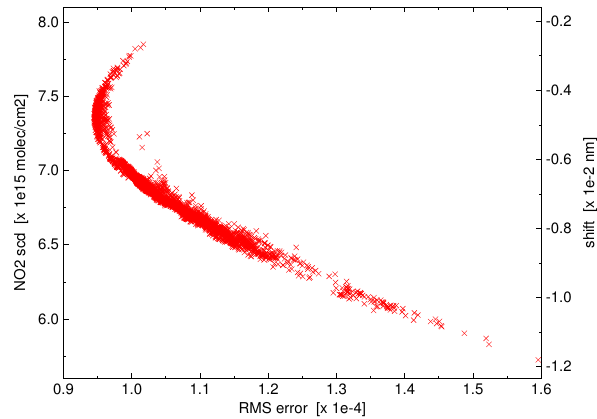
Figure 2. Pacific Ocean test orbit average relationship between the Fig. 2. Pacific Ocean test orbit average relationship between the RMS error and the NO 2 SCD for the 5151 wavelengthcalibrationwindowsinvestigated. Therightaxisofthemainplotisanapproximation: itgivesthe RMS error and the NO 2 SCD for the 5151 wavelength calibration wavelengthshiftconstructedfromthelinearrelationshipwiththeNO 2 SCDmentionedinthetext. windows investigated. The right axis of the main plot is an approx- imation: it gives the wavelength shift constructed from the linear relationship with the NO 2 SCD mentioned in the